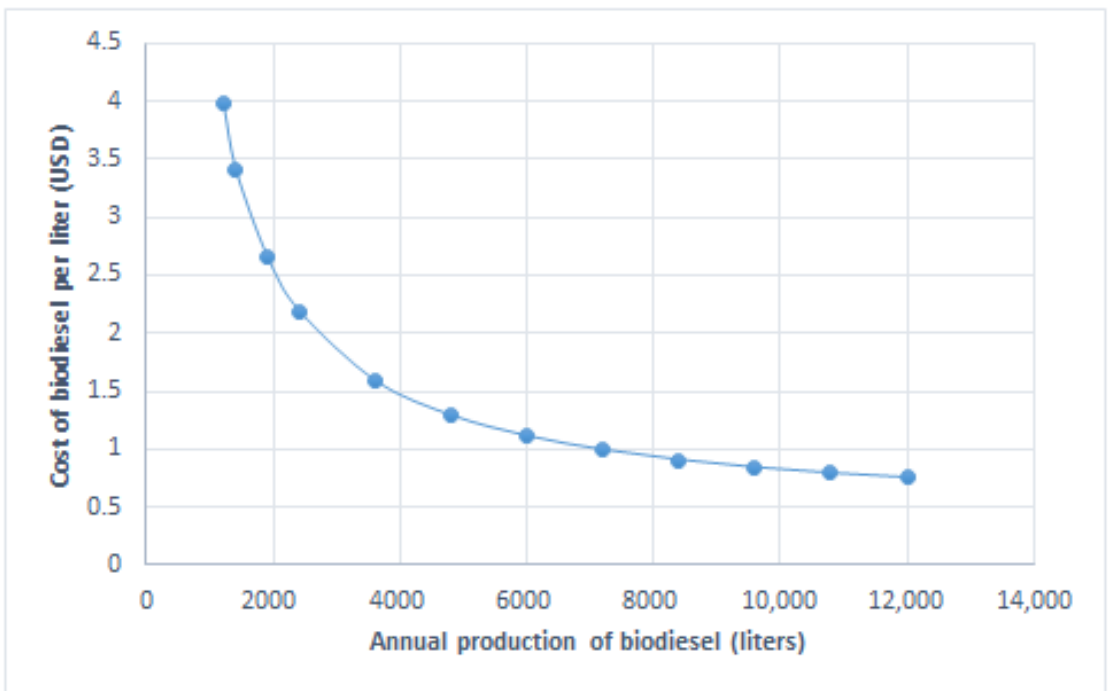
Figure 6. The sensitivity analysis for the cost per liter of distilled biodiesel to its annual production.